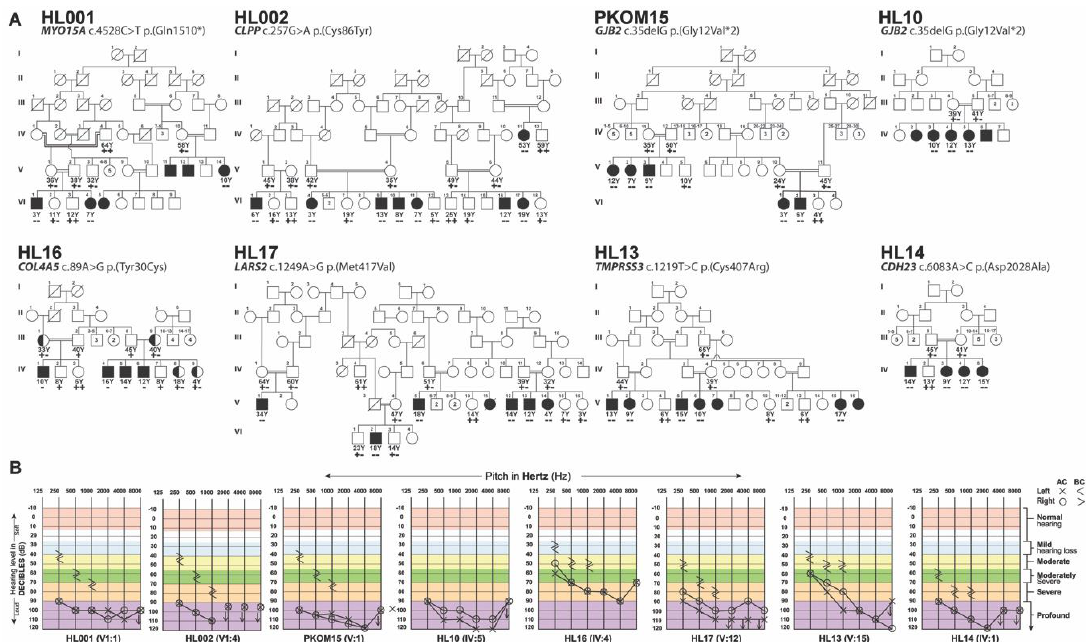
Figure 1. Hearing loss (HL) family pedigrees and causative variants. ( A ) Segregation of disease-causing alleles in eight Pakistani families. Filled and empty symbols represent affected and unaffected individuals, respectively, while half-filled symbols in family HL16 indicate carriers of identified X-linked variants. Double lines indicate consanguineous marriages. The genotypes (wild type, heterozygous, homozygous, or hemizygous) of the identified mutant alleles are also shown for each of the participating family members. All families had autosomal recessive mode of inheritance for HL, except for the family that had sex-linked (X-chromosome) inheritance. ( B ) Representative